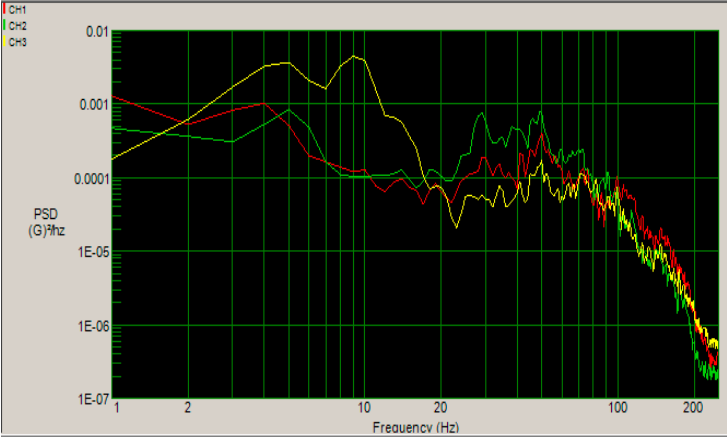
Figure 3. Vibration levels in the time and frequency domains while indoor-outdoor driving.